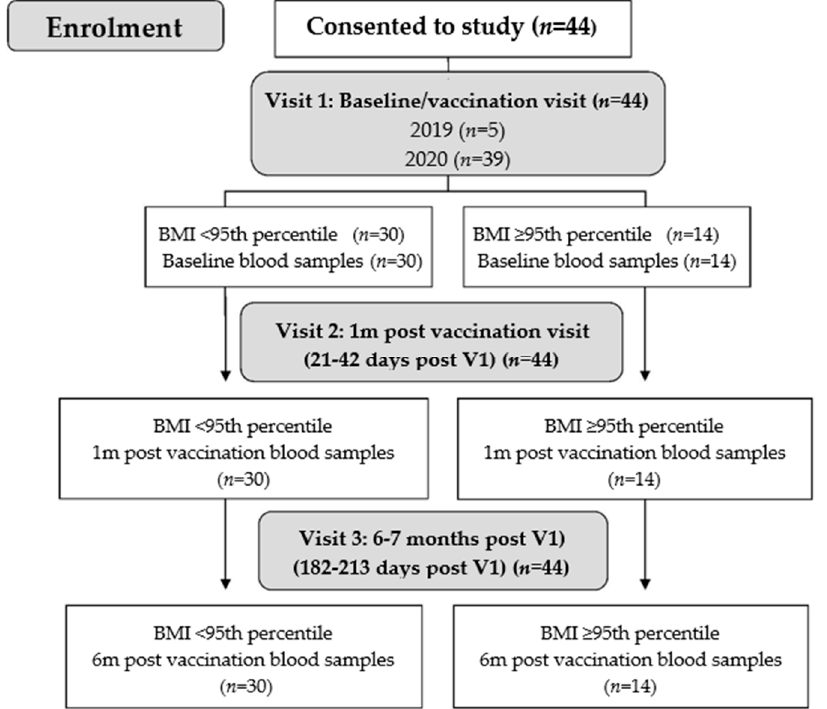
Figure 1. Flowchart of participants and study design.